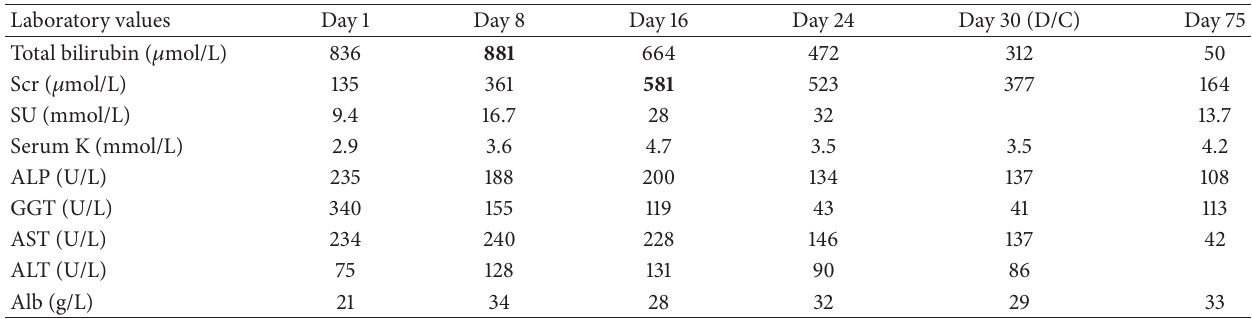
Figure1:(a)Multipletubuleswithdilatationandvacuolization.Tubularlumensdemonstrateheavilypigmentedgranularcasts(blackarrows). (b) Multiple densely stained cellular and granular casts in the tubular lumen (black arrows) (haematoxylin and eosin stain). Table 1: Pertinent laboratory